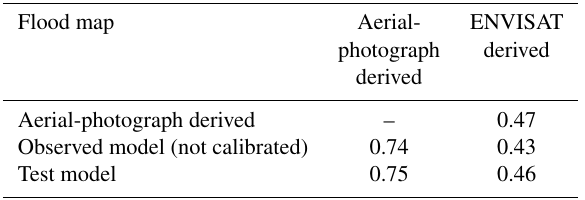
Table 4. CSI scores for July 2007 flood extent maps comparing re- sults obtained using ENVISAT WSM SAR- and aerial-derived flood extents with hydraulic-model-generated flood extent.